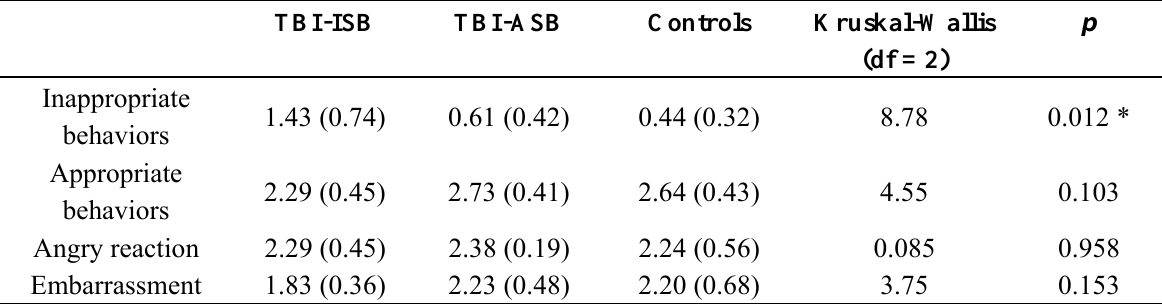
Table 2. Mean scores (standard deviation) by group for inappropriate behavior, appropriate behavior, expectation of angry reaction from others and of feelings of embarrassment, and results of Kruskal–Wallis